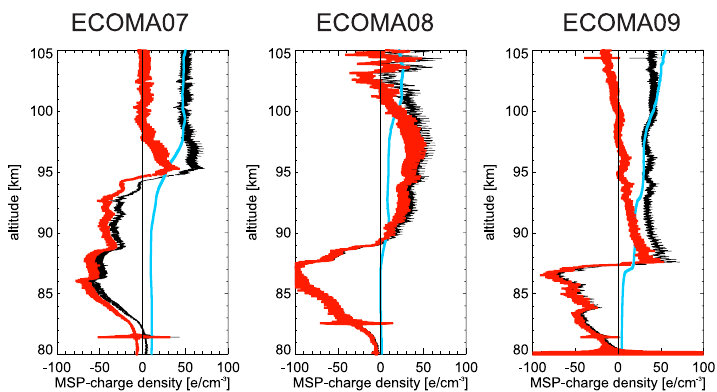
Fig. 5. Overview of all Faraday cup measurements of charged MSP obtained during ECOMA-2010. Black lines show upleg-data. Light blue lines show downleg data smoothed over 5000 data points. Taking the difference between both allows us to largely eliminate contamination due to positive ions (see text for details). The corrected profiles are shown in red.